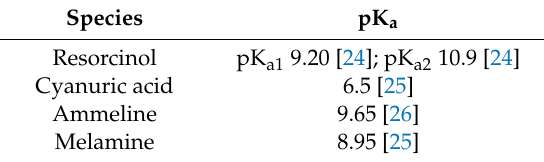
Table 1. pK a values for resorcinol and s-triazine species used in this